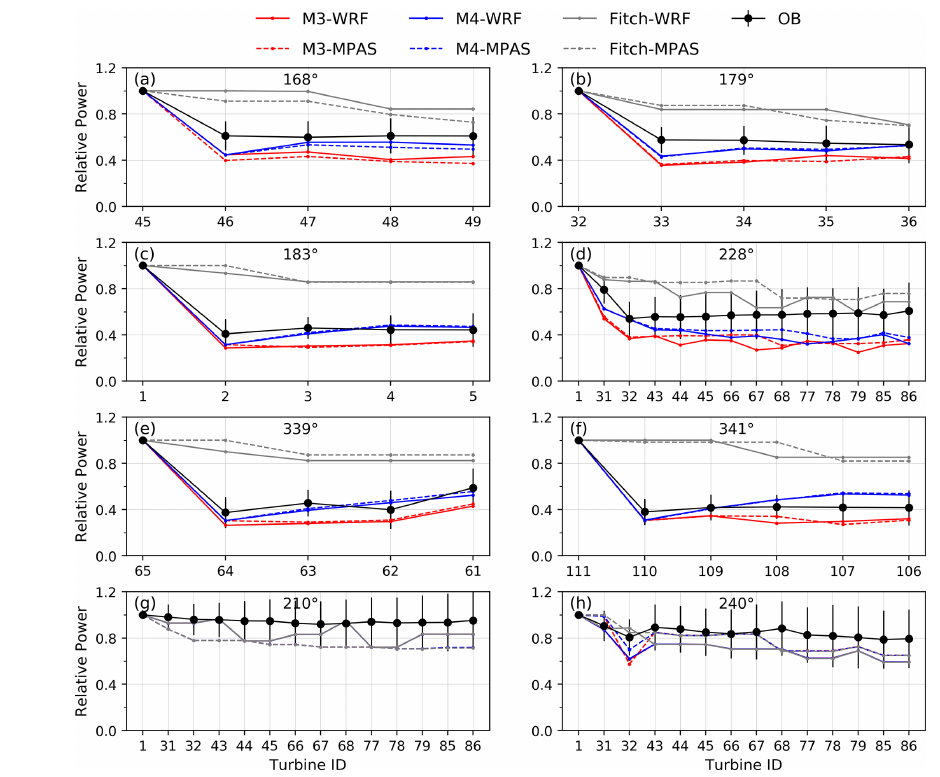
Figure 8. Same as Fig. 4 but for Anholt multi-cell cases with (cid:49)x = 2km.